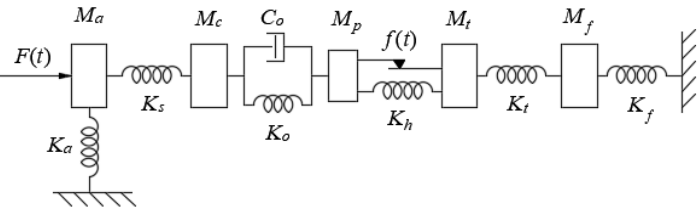
Figure 13. Mathematical model of test rig with friction damper.